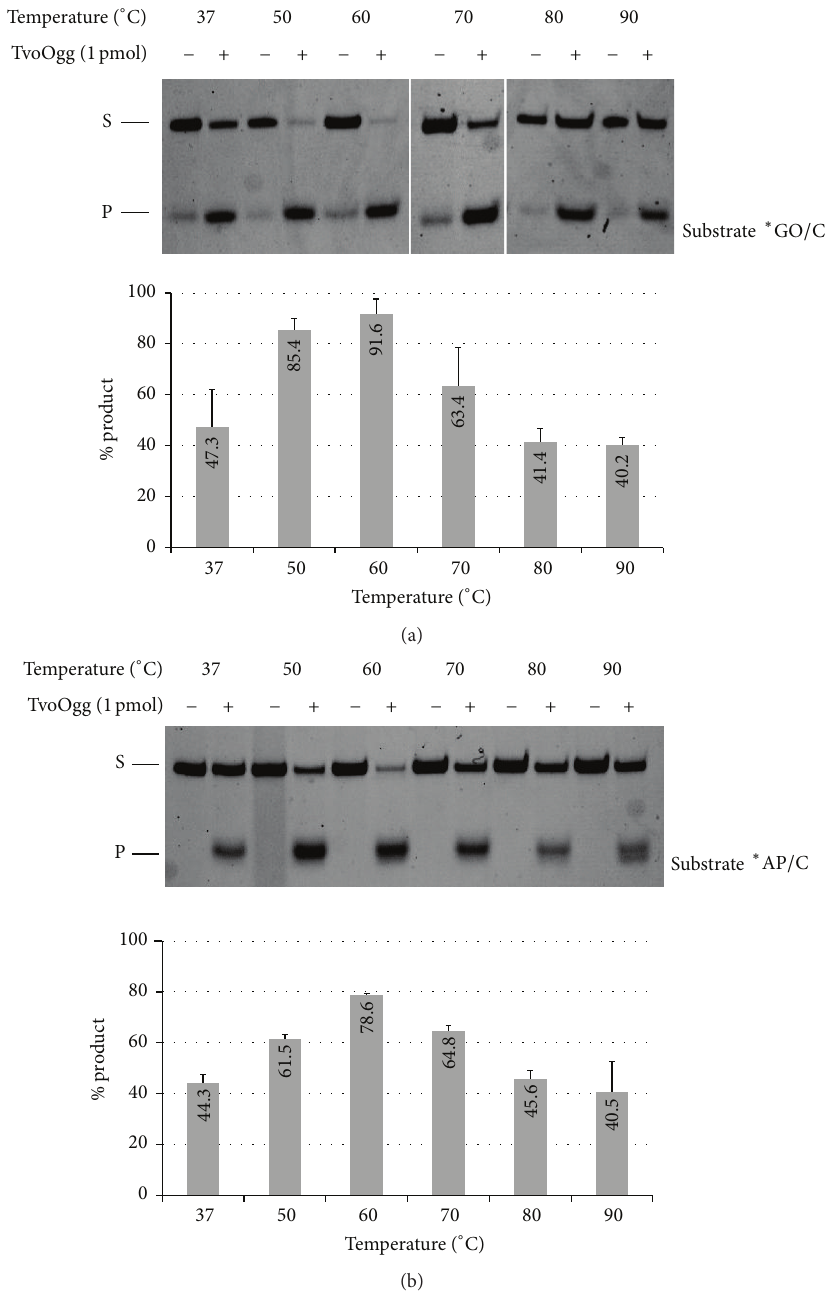
Figure 3: Temperature dependency of GO glycosylase activity (a), or AP lyase activity (b), in the presence (+) or absence ( − ) of 1pmol of TvoOgg with a 34-bp heteroduplex DNA containing GO/C (a) or AP/C (b), respectively, mismatched at different temperatures for 30 min. The strand containing GO and AP was 5 󸀠 -end labeled with FAM. The uncut 34-mer DNA substrate (S) and cleaved 13-mer product (P) were indicated on the left. The signal intensities of each product were measured and quantified with Pharos FX. Data are presented as the mean ± SD of three independent measurements. Asterisks indicate the 5 󸀠 -end labeled